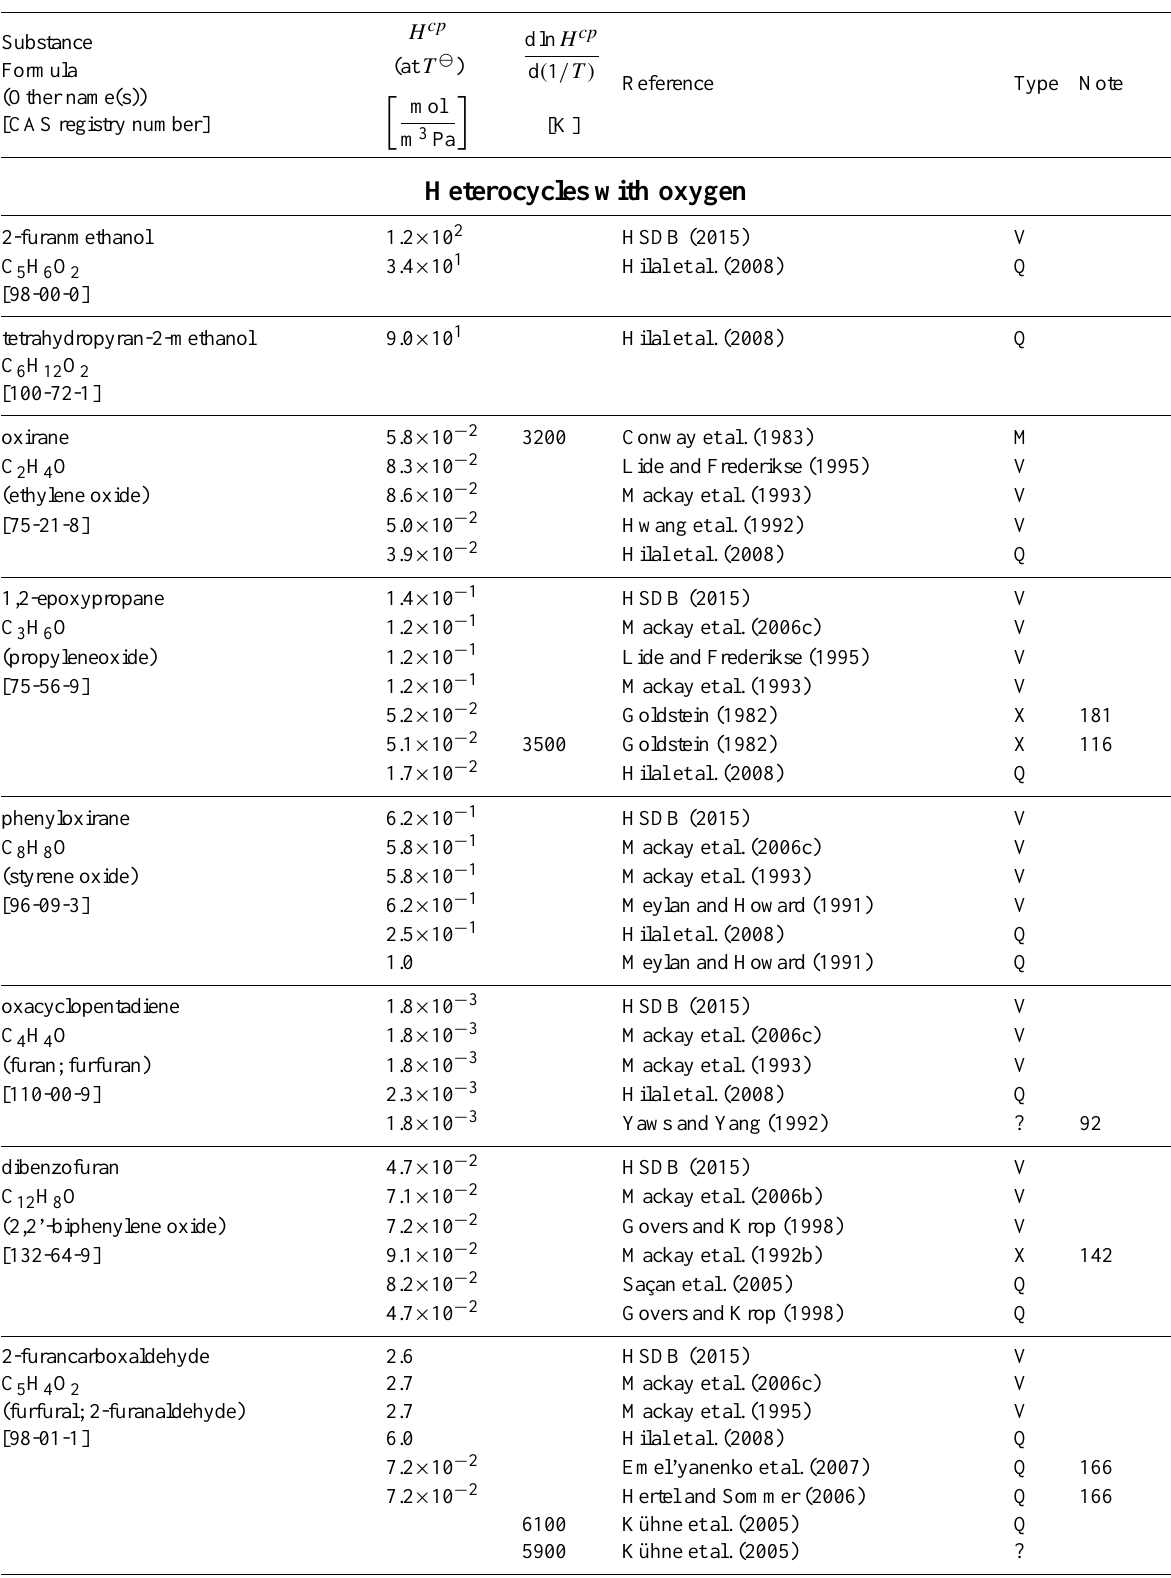
Table 6: Henry’s law constants for water as solvent